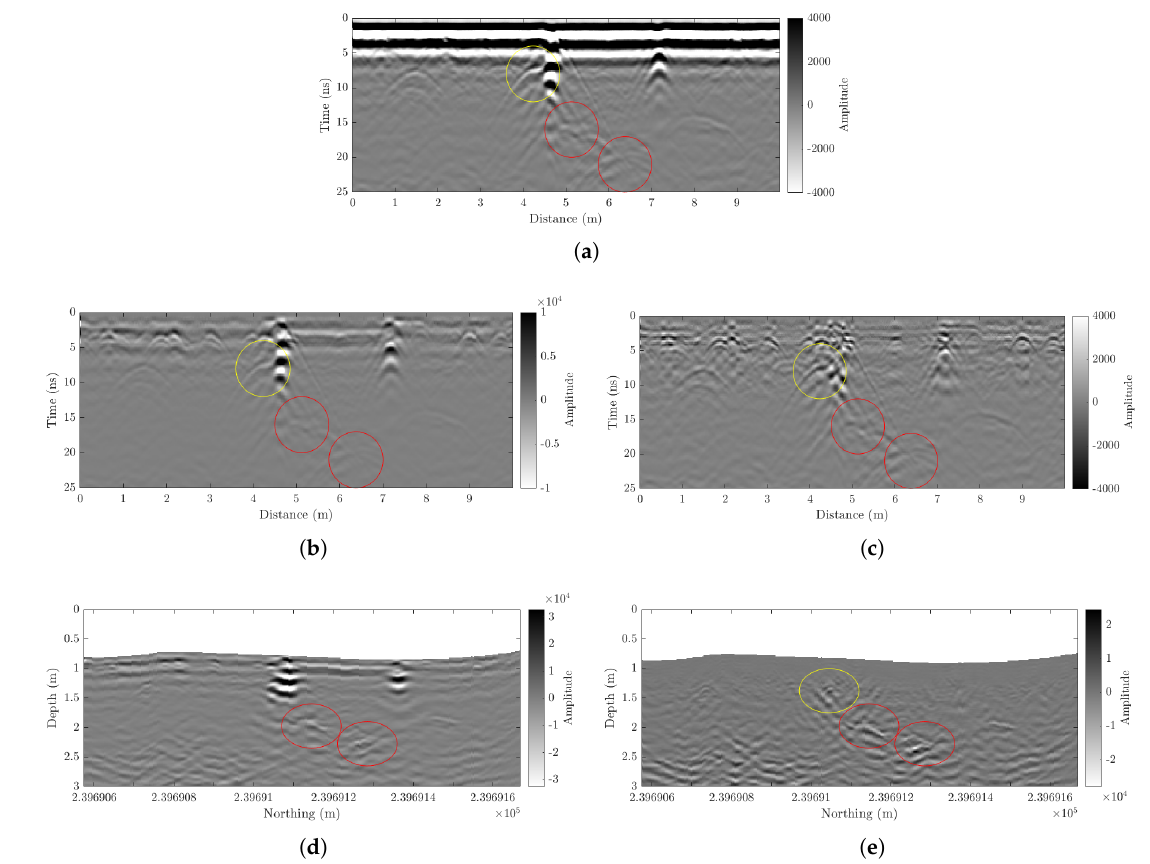
Figure 2. GPR profile crossing plot bounded by railroad ties (see red bold line in Figure 1a. Profiles are only plotted to 25 ns to focus on area of interest. ( a ): GPR profile crossing over the two Wilson graves (red circles). The sharp ringing produced by railroad ties (x = 4.5, 7 m) overprint a diffraction pattern (yellow circle). Note: The plot contrast is increased for illustrative purposes. ( b ): Mean trace subtraction is successful at removing much of the direct wave, but not the ringing. ( c ): An eigenimage highpass completely removes the direct wave and most of the ringing to reveal a clear diffraction pattern (yellow circle). A large percentage of amplitude is removed during this filtering process, which explains the smaller range of amplitude values. A grid-wide, post-migration, topographic correction is done using TLS elevations. This correction is applied to the dataset where a mean trace background removal is used to remove the direct wave ( d ) and SVD-filtered data where the direct wave and ringing is removed ( e ). ( a ) Original Profile. ( b ) Mean trace subtraction. ( c ) SVD Eigenimage Highpass. ( d ) No SVD; topography from TLS. ( e ) Eigenimage Highpass; topography from